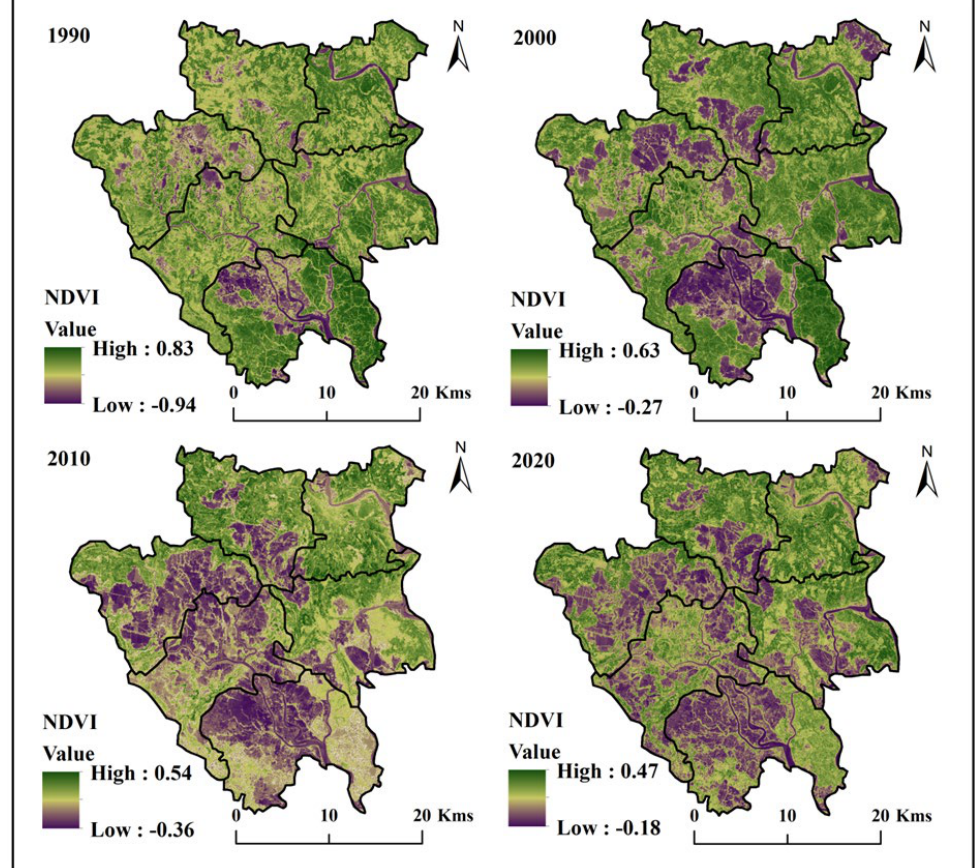
Figure 8. Normalized Different Vegetation Index (NDVI) maps of the study area.